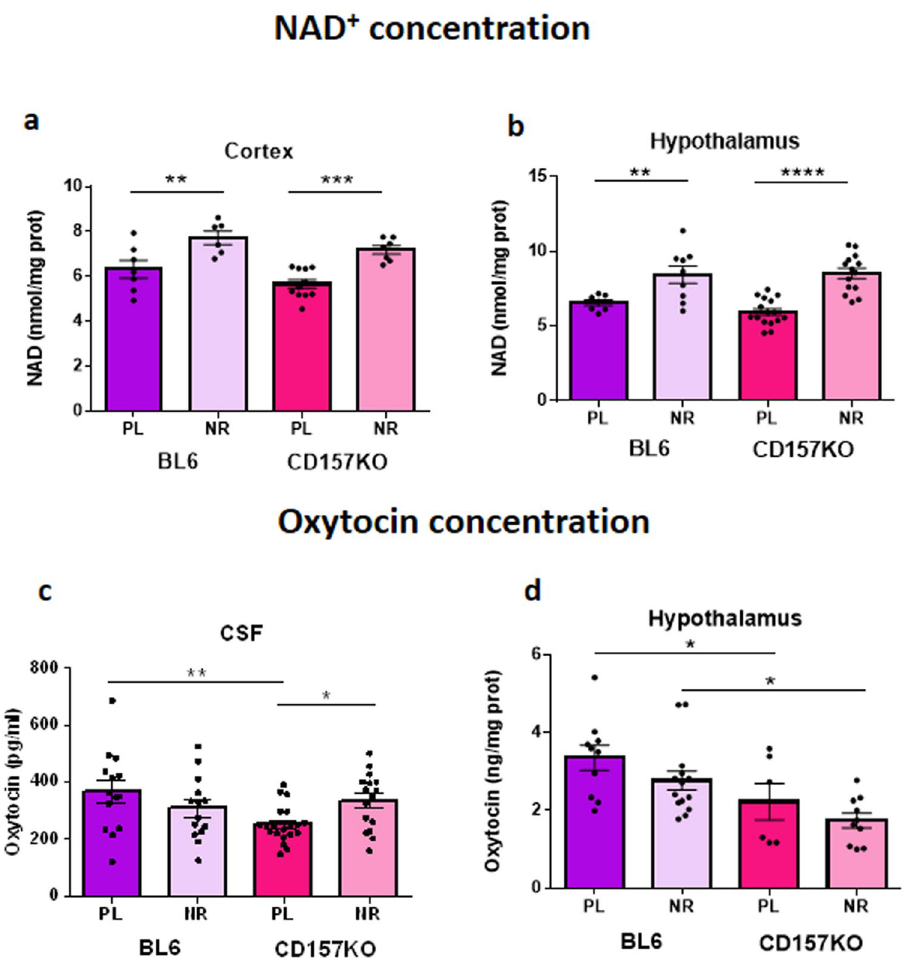
Figure 6. NAD + and OT levels were determined in the cortex and hypothalamus or cerebrospinal fluid (CSF) of wild-type (BL6) and CD157KO mice treated with NR. ( a,b ) NR gavage at 3 mg/mouse for 12 days significantly elevated NAD + concentrations in mice of both genotypes in the cortex (two-way ANOVA; the effect of treatment ( F 1,27 = 28.33, P < 0.0001) and the effect of genotype ( F 1,27 = 4.74, P = 0.0384) and the hypothalamus (two-way ANOVA; the effect of treatment ( F 1,42 = 36.58, P < 0.0001). Bonferroni’s post hoc comparison shows a significant difference between placebo and NR in CD157KO mice ( P < 0.05)), comparing saline treatment (PL). ( c ) The identical treatment of NR significantly increased OT concentrations in the CSF of CD157KO mice (Two-way ANOVA revealed a significant effect of interaction between treatment and genotypes ( F 1,60 = 7.341, P = 0.0088). Bonferroni’s post hoc comparison shows a significant difference between placebo and NR in CD157KO mice ( P < 0.05). ( d ) OT concentrations in the hypothalamus in wild-type and CD157KO mice showed no significant difference after treatment with NR (Two-way ANOVA showed the only effect of genotype ( F 1,36 = 12.59, P = 0.0011). * P < 0.05, ** P < 0.01, *** P < 0.001, and **** P < 0.0001,